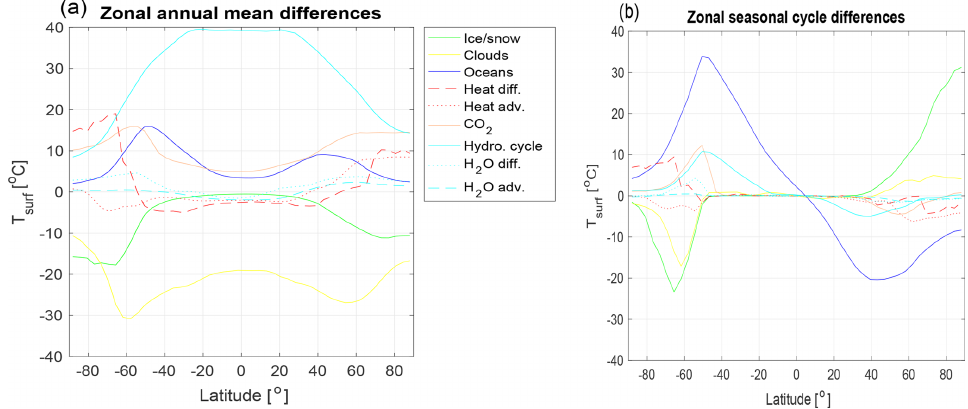
Figure 7. Zonal mean values of the annual mean (a) and seasonal cycle differences (b) for the experiments as shown in Figs. 5 and 6g. The mean for the hydrological cycle is for the experiments with and without the ice–albedo process active.